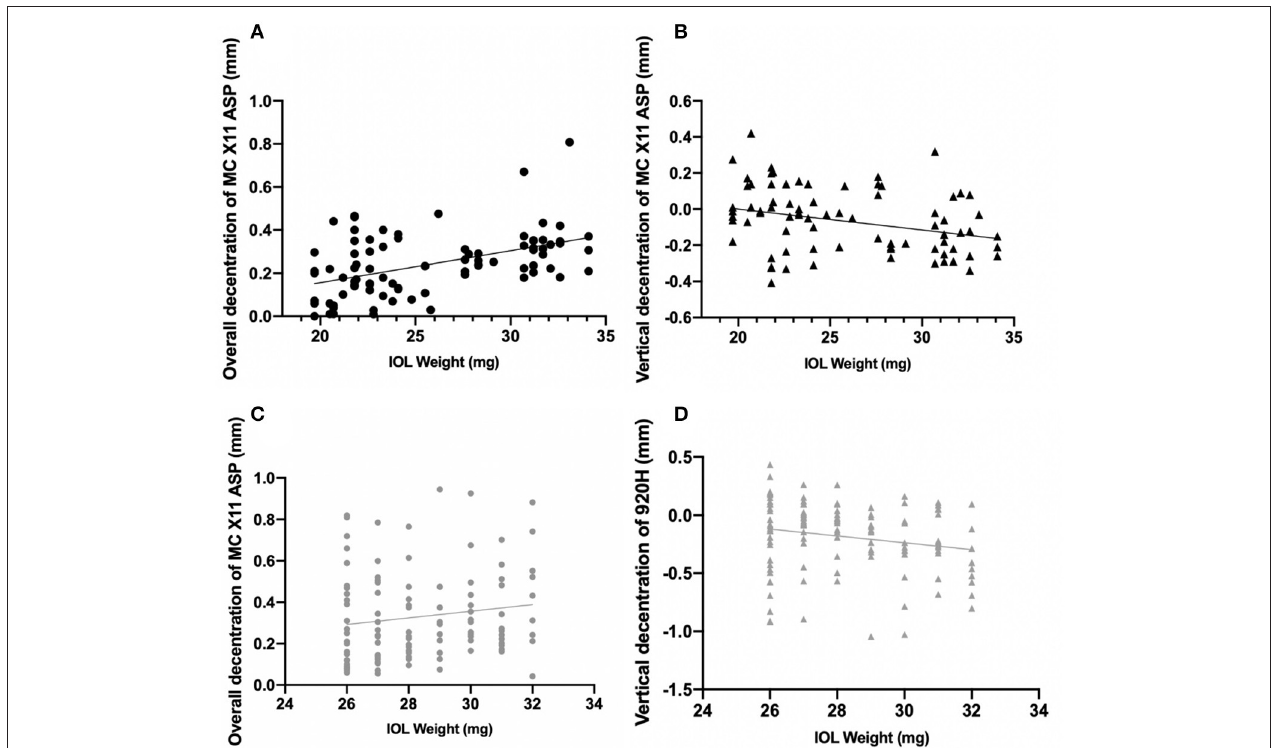
FIGURE 3 | Correlations between decentration of intraocular lenses and IOL weight. (A) The black line indicates the overall decentration was positively correlated with IOL weight in Group A ( r = 0.471, P < 0.001). (B) The black line indicates the vertical decentration was negatively correlated with IOL weight in Group A ( r = 0.234, P = 0.01). (C) The gray line indicates the overall decentration was positively correlated with IOL weight in Group B ( r = 0.234, P = 0.01). (D) The gray line indicates the vertical decentration was negatively correlated with IOL weight in Group B ( r = − 0.193, P = 0.036).